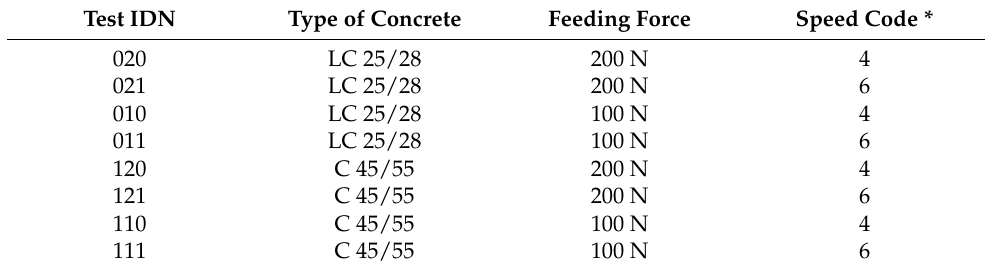
Table 1. Testing matrix table.